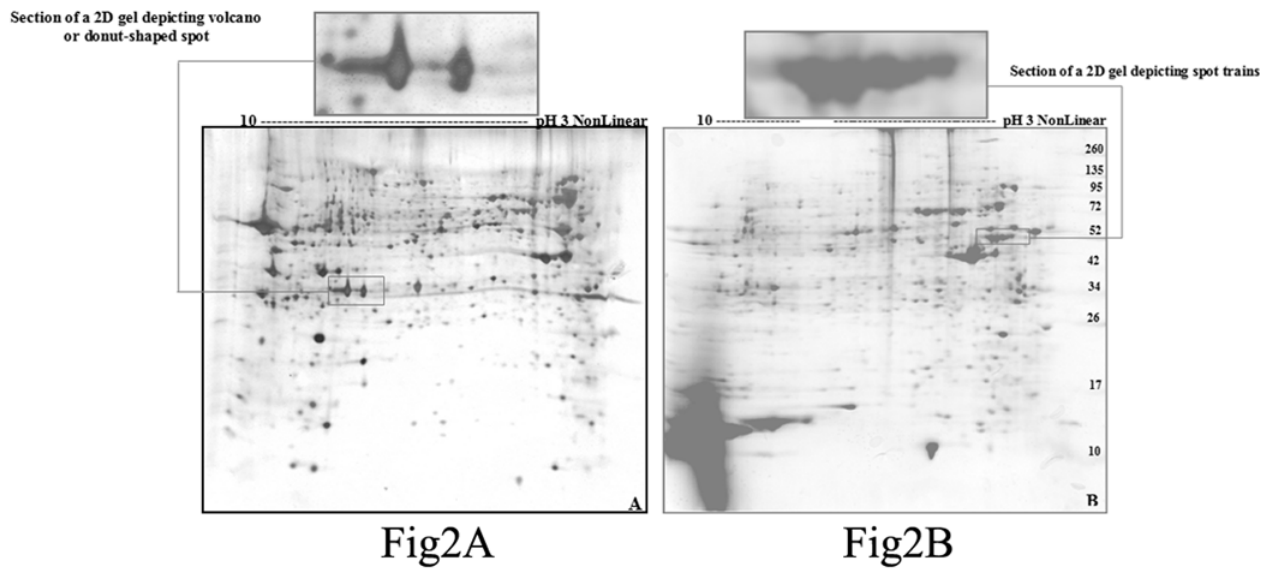
Fig 2. Two-dimensional reference map of the Toxoplasma gondii strain RH. The total tachyzoite proteins of Toxoplasma gondii strain RH were resolved by isoelectric focusing (IEF) and separated across the pH range 3 – 10 (18cm), 12% acrylamide. The polypeptide spots were visualized with silver stain. (A) and Coomassie brilliant blue G-250 (B). Molecular weight standards are shown in the right hand